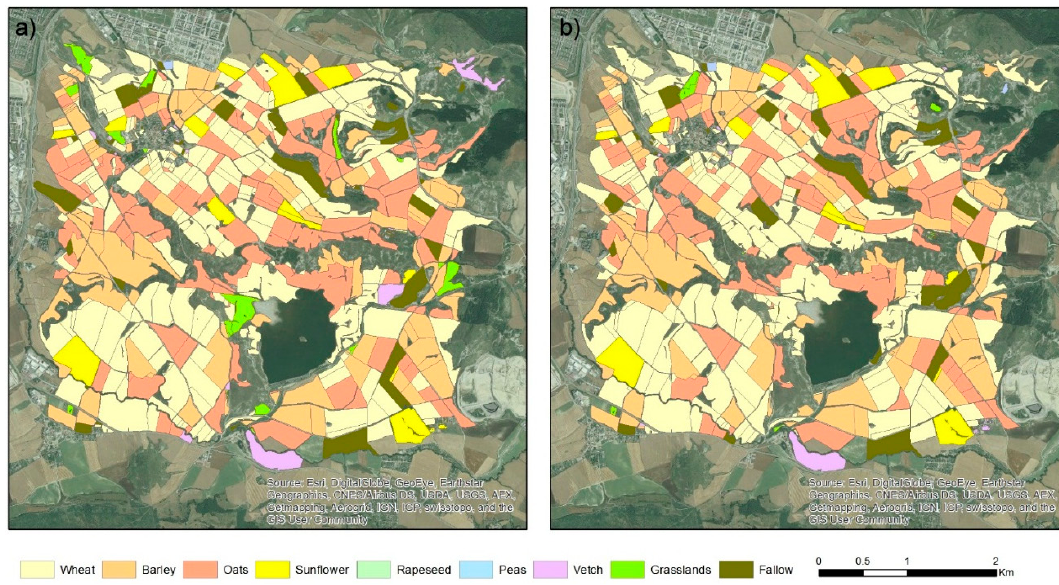
Figure 8. Classification maps for a sample agricultural district: ( a ) corresponds to classification model 0 (dual pol) and ( b ) to model 8 (quad pol including all the polarimetric features).